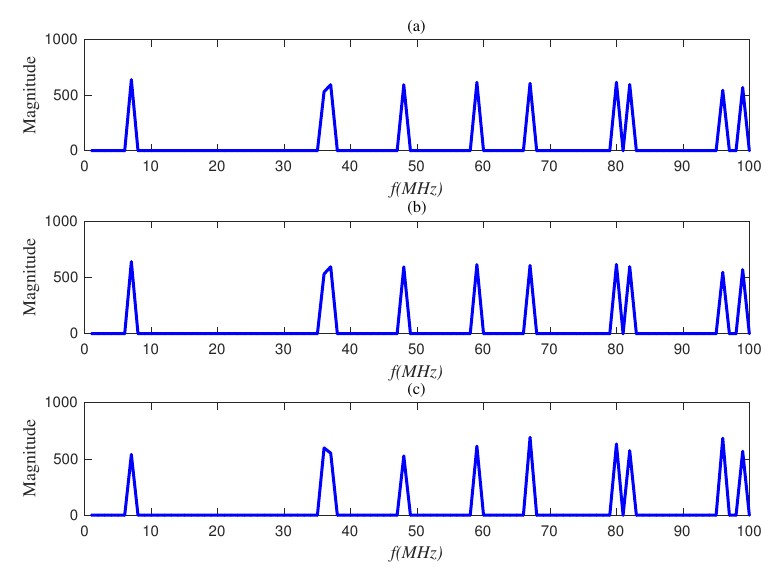
Figure 6. Comparison of the original signal and the STP-CSS reconstructed signal when M = 100: ( a ) the original energy, ( b ) the reconstructed energy of the compressed spectrum sensing algorithm, and ( c ) the reconstructed energy of the semi-tensor compressed spectrum sensing algorithm.